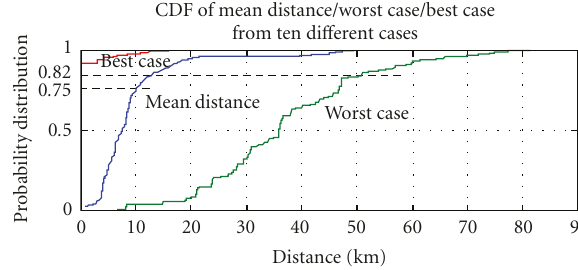
Figure 13: The CDF of mean distance/best case/worst case with di ff erent random points sets in half distance scheme.